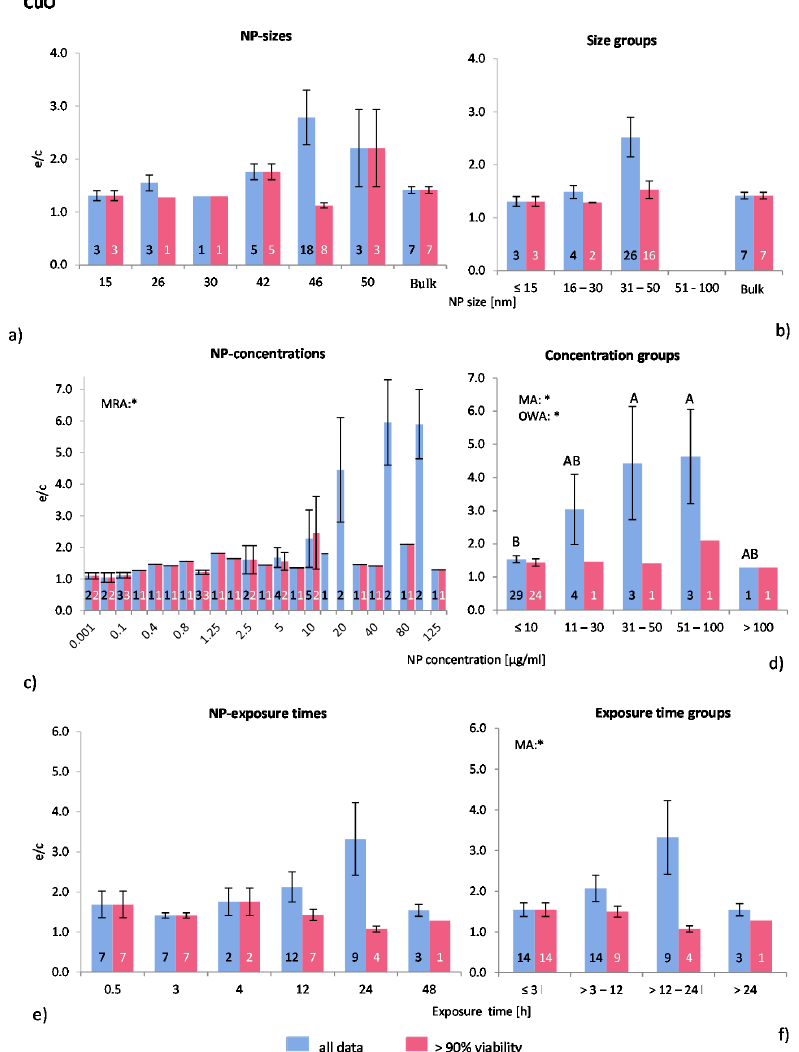
Figure 6. The effect of NP-size, concentration and exposure time on ROS ratios after exposure to CuO-NP. Data are illustrated as mean ˘ SEM and numbers inside the bars represent the number of investigations. Mean ROS ratios as a function of ( a ) NP-size, ( c ) NP-concentration and ( e ) exposure times are shown. Multiple Regression Analysis (MRA) was used to identify correlations between the independent variables NP size, concentration or exposure time and the dependent variable ROS ratio; ( b , d , f ) show the respective groupings that were analyzed with multi-factor ANOVA (MA) for statistical significant inhomogeneity for three variables, one-way ANOVA (OWA) for one variable, and the modified post-hoc Tukey test for unequal n for group differences. The bars labelled “a” or “A” etc. are statistically different from “b” or “B” but not from “ab” or” AB”. p < 0.05 for * all data and # for >90%